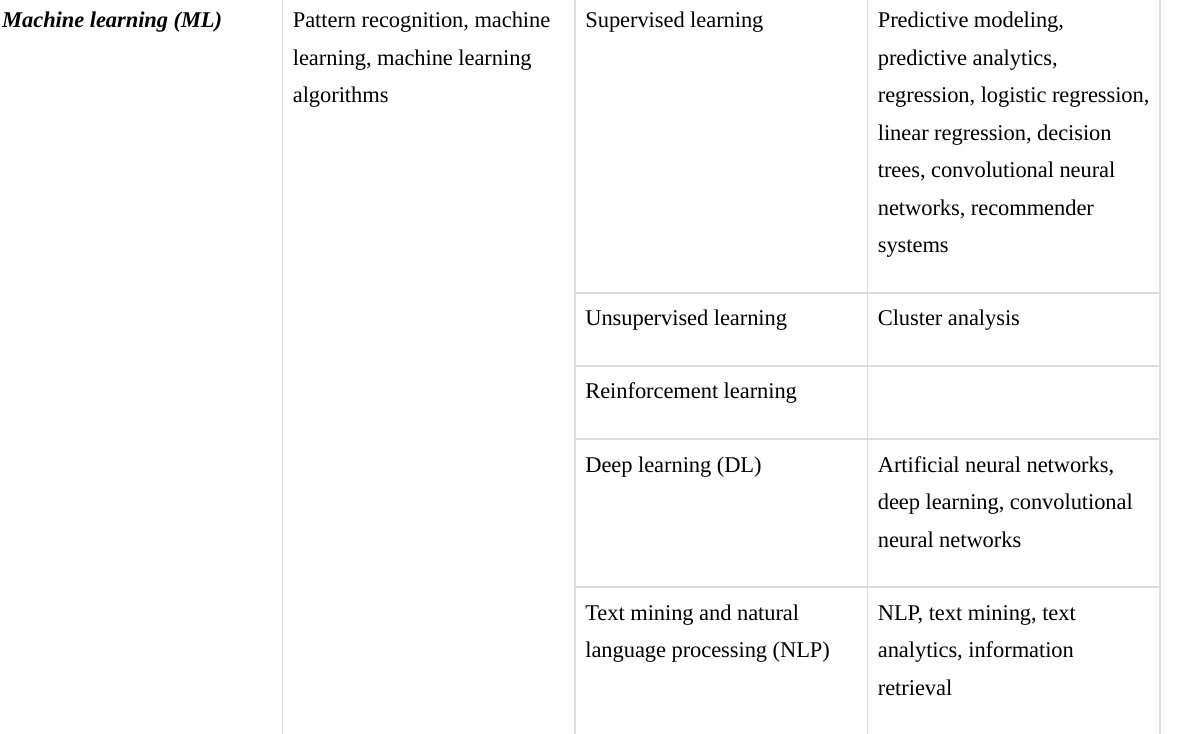
The average frequencies of these key phrases base our subject classification for the roles. In Figure B1, we show the average frequencies of the subject-related key phrases in LinkedIn job postings and professional